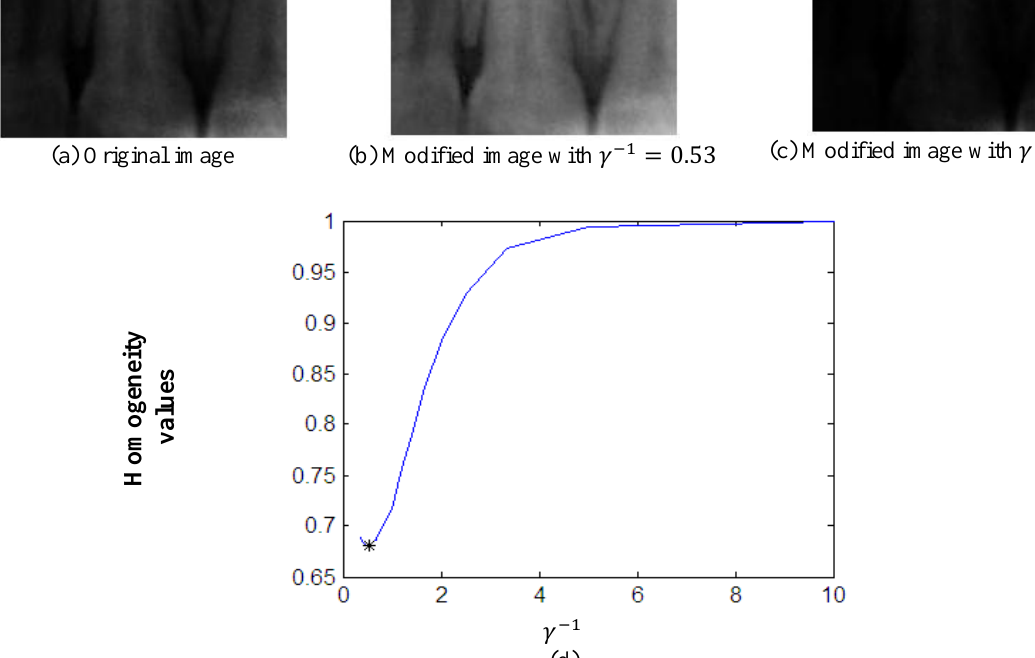
Figure 4. Diagram of homogeneity values for thirty different inverse gamma images from 0.1 to 3. The deep point represented by the asterisk reaches a unique minimum at 𝛄 −𝟏 = 𝟎. 𝟓𝟑